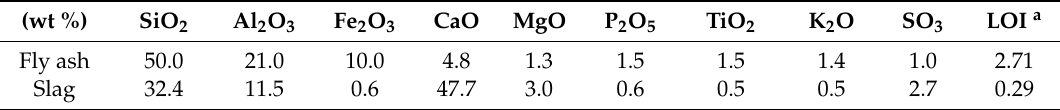
Table 1. Chemical composition of fly ash and slag used in this study.